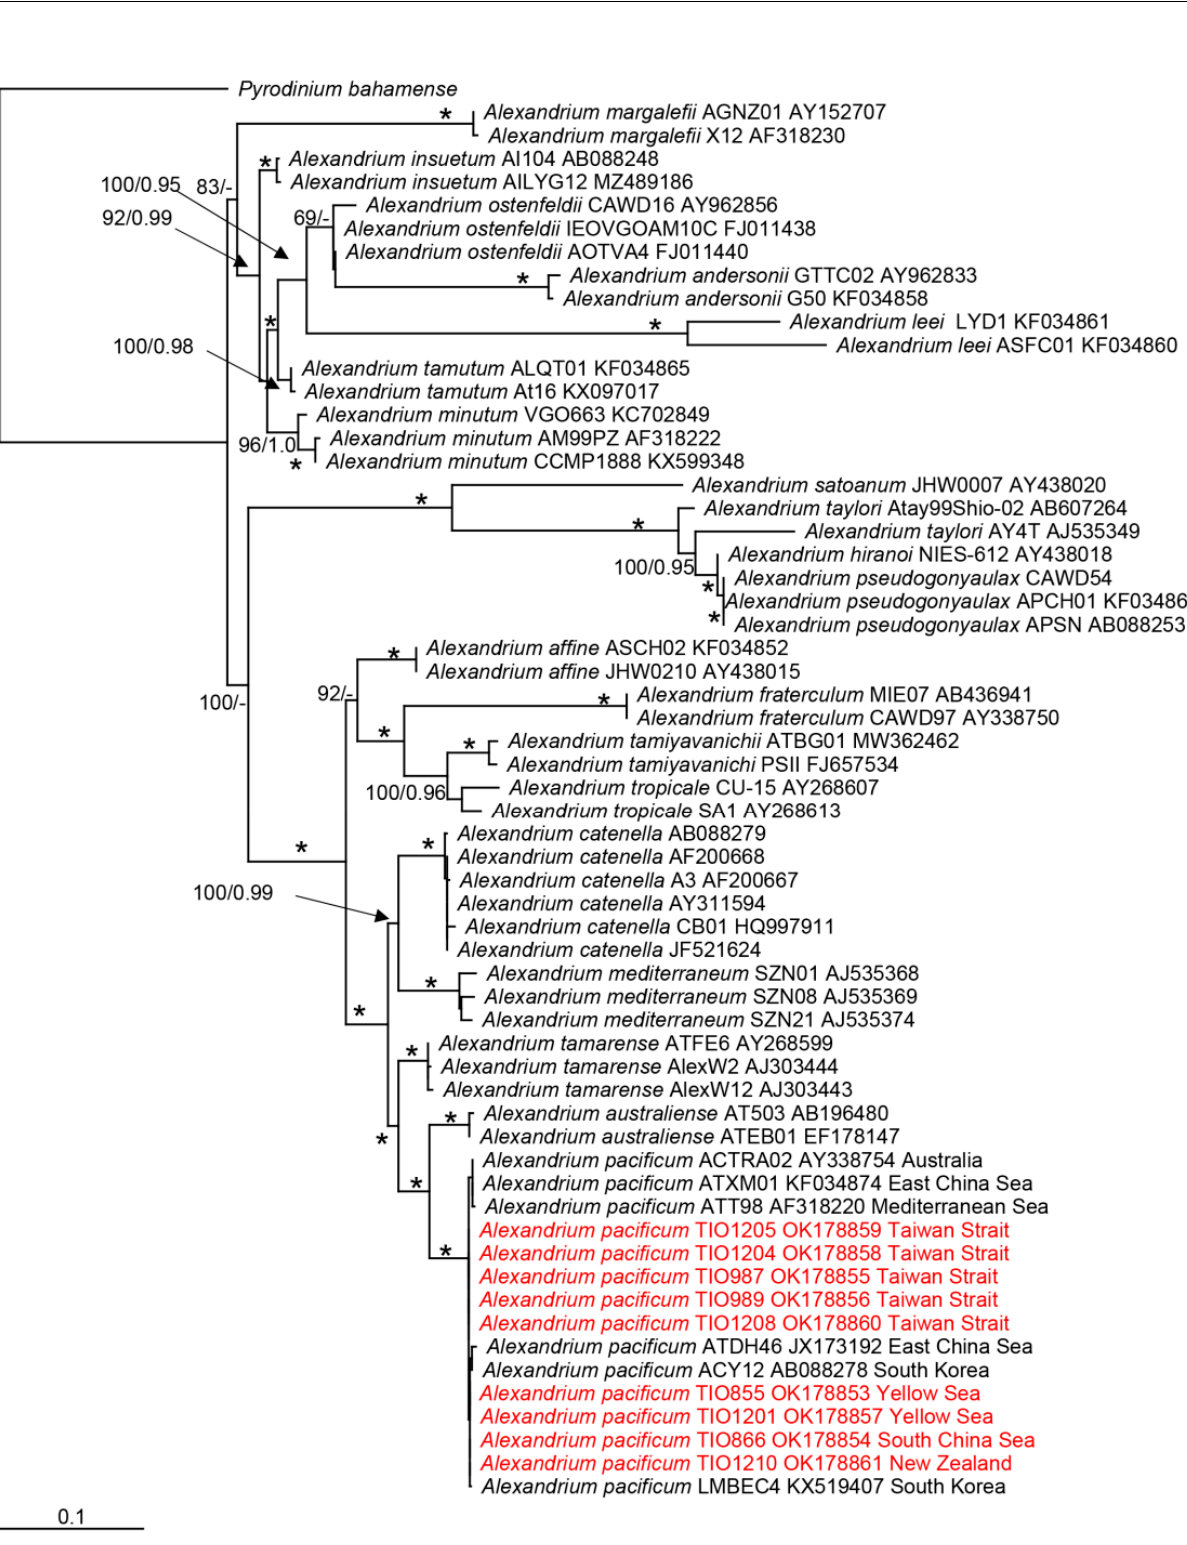
Figure 2. Molecular phylogeny of Alexandrium pacificum inferred from partial LSU rRNA (D1–D6) sequences using maximum likelihood (ML). New sequences are indicated in red. Branch lengths are drawn to scale, with the scale bar indicating the number of nucleotide substitutions per site. Numbers on branches are statistical support values to clusters on the right of them ( left : ML bootstrap support (BS) values; right : Bayesian posterior probabilities (BPP). BS values > 50% and BPP above 0.9 are shown. * indicates maximal support (BS = 100% and BPP = 1.00).